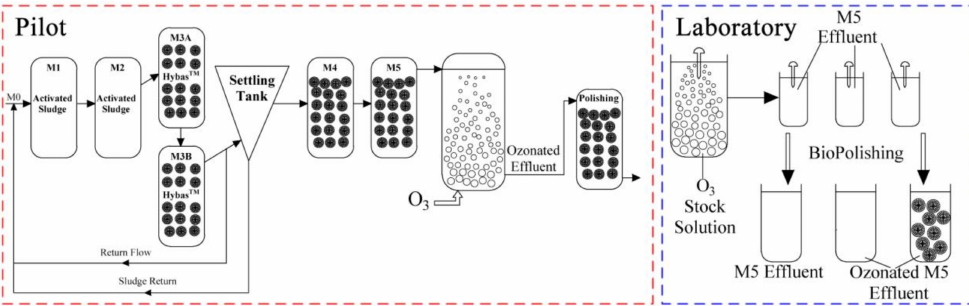
Figure 1. Schematic diagram of a five-stage pilot-scale MBBR treatment train followed by a pilot-scale ozonation and a polishing MBBR ( left ). ‘M0’ stands for the municipal wastewater inlet. A laboratory-scale MBBR was used to polish ozonated e ffl uent in the laboratory ( right ).